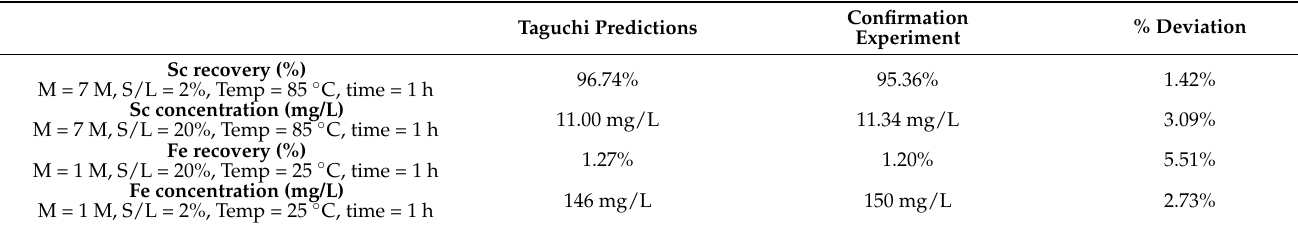
Table 5. Comparison of Taguchi predictions and confirmation experiment results.